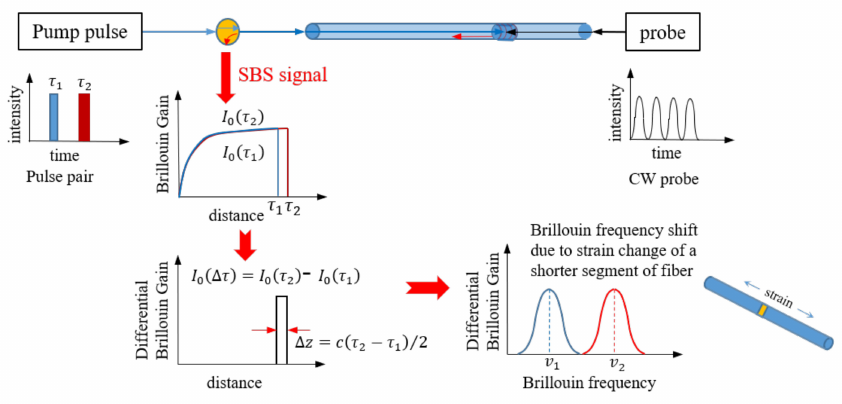
Figure 1. Working mechanism of DPP-BOTDA based distributed strain sensing.